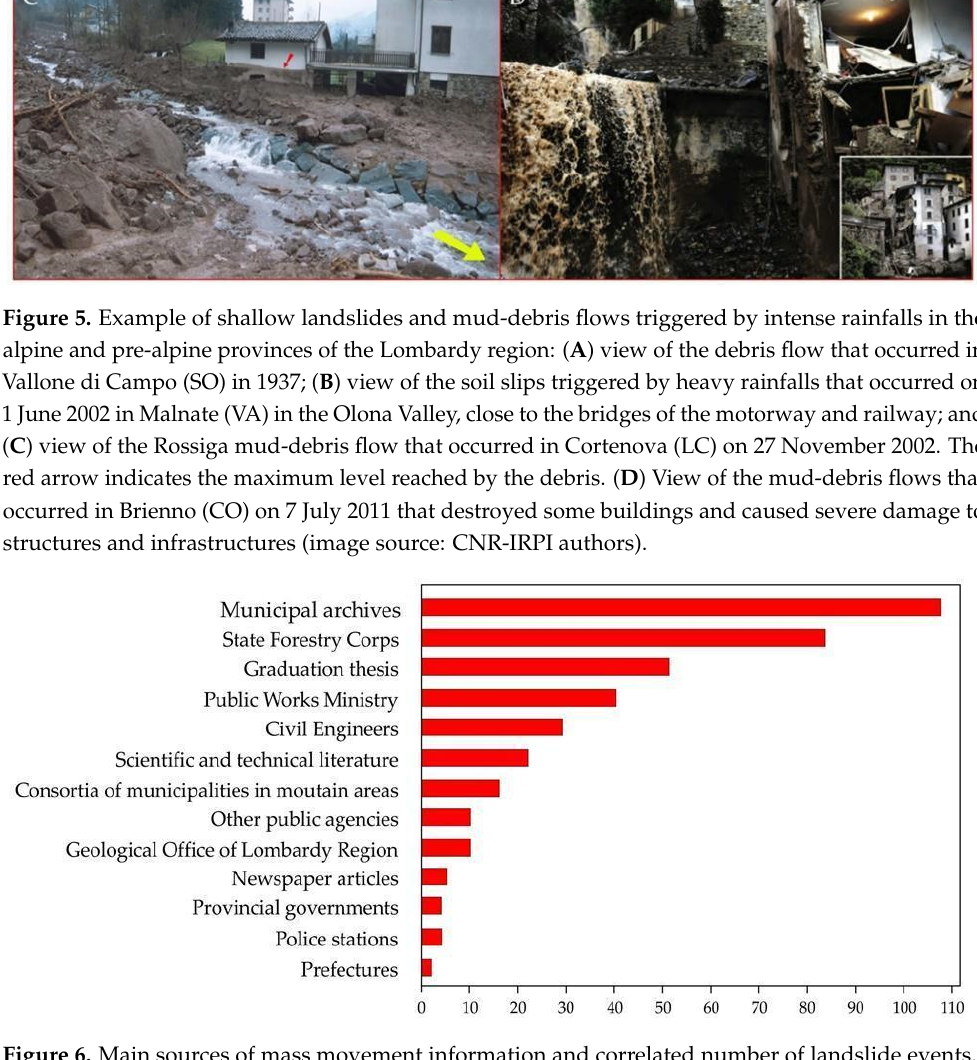
Figure 6. Main sources of mass movement information and correlated number of landslide